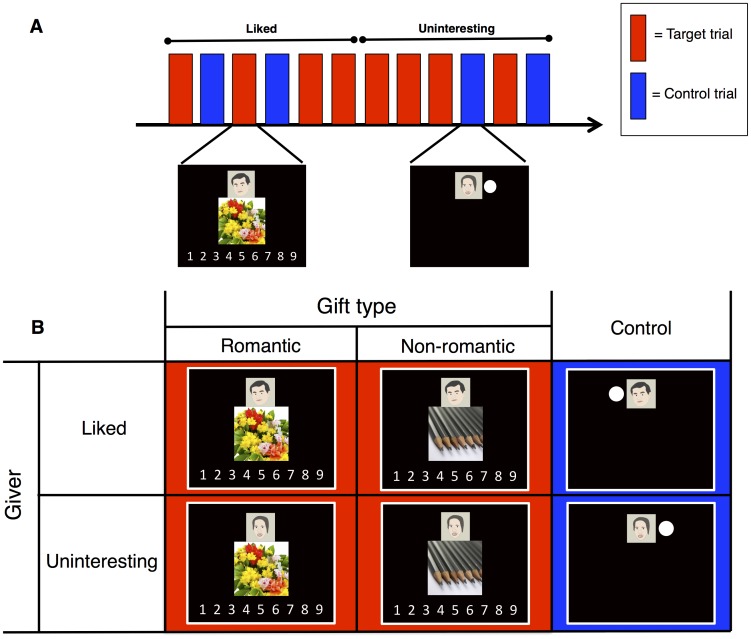
The fMRI task.(A) The task was conducted in an event-related design. Six trials from either the liked or the uninteresting male acquaintance were combined in a set. Each set contained pseudo-randomized four target trials (shown in red) with two control trials (shown in blue). (B) Each trial was created by a 2 × 3 factorial design. In a target trial, female participants judged the gift attractiveness (1: the least attractive, 9: the most attractive). In a control trial, the participants simply pressed the button when a white dot appeared by the side of the portrait. For details, see Materials and Methods.